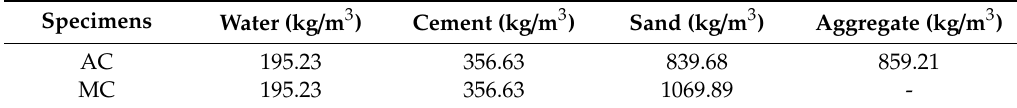
Table 1. The proportion of materials used in the